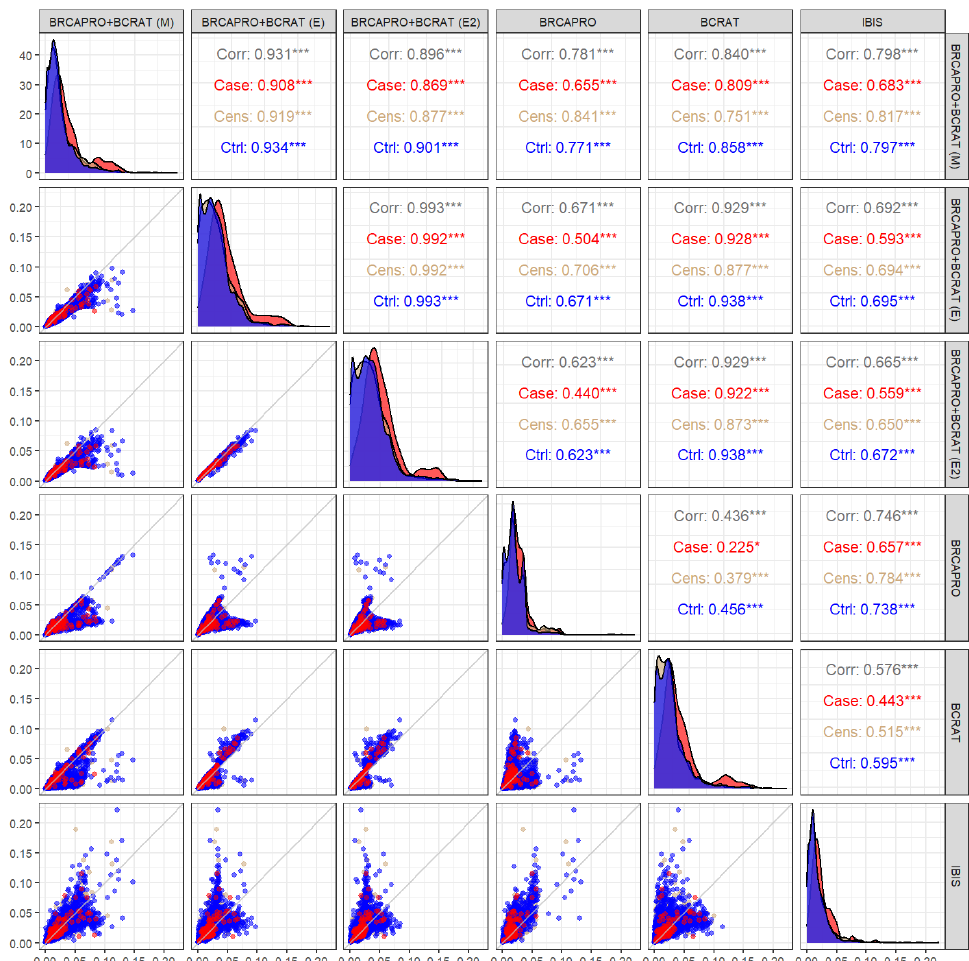
Figure 3. Scatter plots, density plots, and pairwise correlations of five-year predictions in the CGN data. Red corresponds to data from cases, blue corresponds to data from controls (individuals who did not develop breast cancer within five years), and beige corresponds to data from counselees censored before five years. Corr: Pearson correlation, cens: counselees censored before five years, ctrl: controls. The lower diagonal panels show scatter plots of the predictions from each pair of models. For example, the panel in the second row, first column has predictions from BRCAPRO + BCRAT (E) on the x-axis and predictions from BRCAPRO + BCRAT (M) on the y-axis. The diagonal panels show density plots of the predictions from each model, stratified by case-control status. For example, the panel in the first row, first column shows the distribution of predictions from BRCAPRO + BCRAT (M). The upper diagonal panels show the Pearson correlations between predictions from each pair of models. For example, the first row, second column shows the overall correlation, correlation among cases, correlation among censored counselees, and correlation among controls for predictions from BRCAPRO + BCRAT (M) and BRCAPRO + BCRAT (E). *** = p <